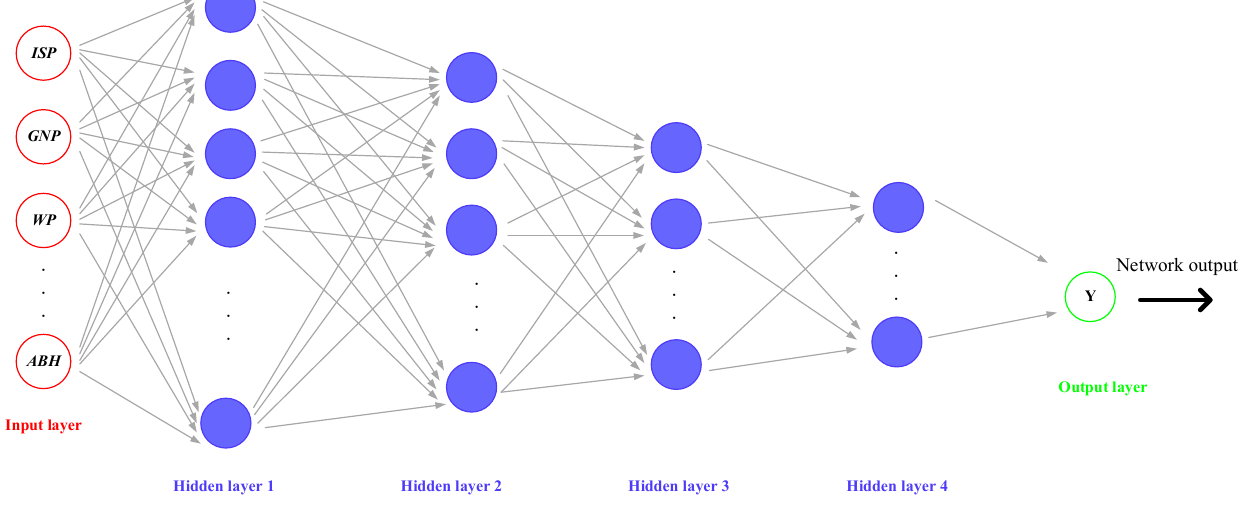
Figure 5. FNN model structure of the study. To date, a variety of neural network models have been established, among which the most widely used is the error backpropagation neural network, referred to as a fully connected neural network. Mean absolute error (MAE) represents the mean of the absolute error between the predicted and observed values. Root mean square error (RMSE) measures the deviation between the predicted and true values and is more sensitive to outliers in the data. The MAE and RMSE are calculated as follows: